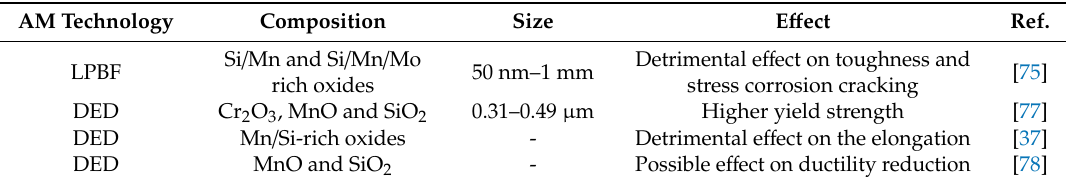
Table 3. A summary of the composition and size of oxides found in AM AISI 316L alloy.